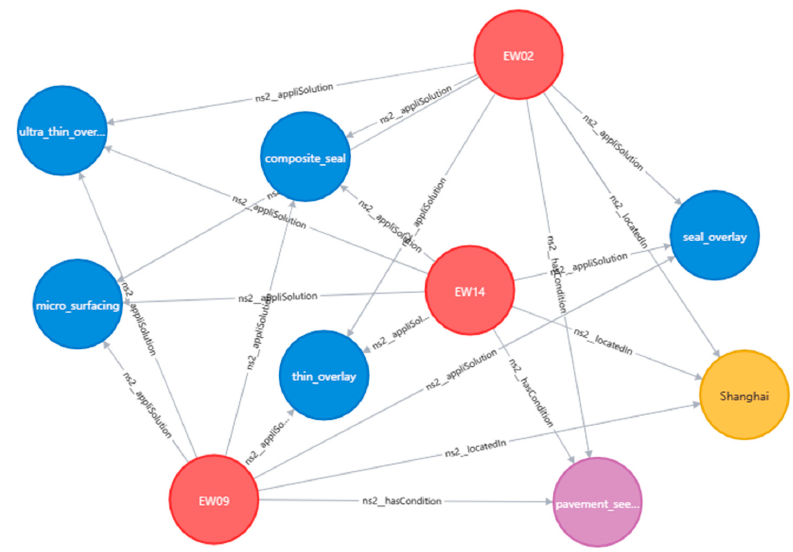
Figure 8. Results based on knowledge reasoning and case similarity.